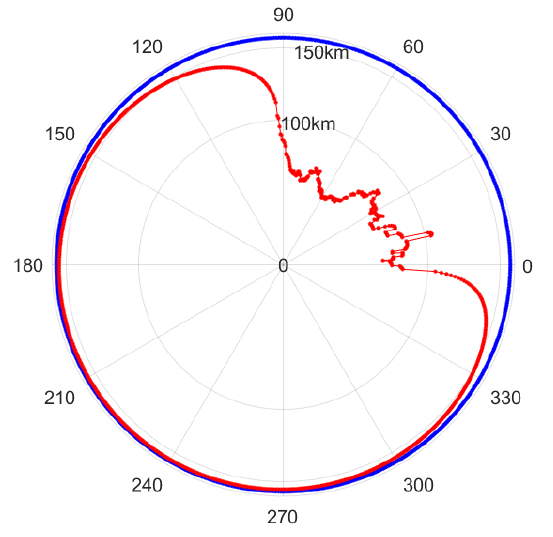
Figure 8. Radar detection power